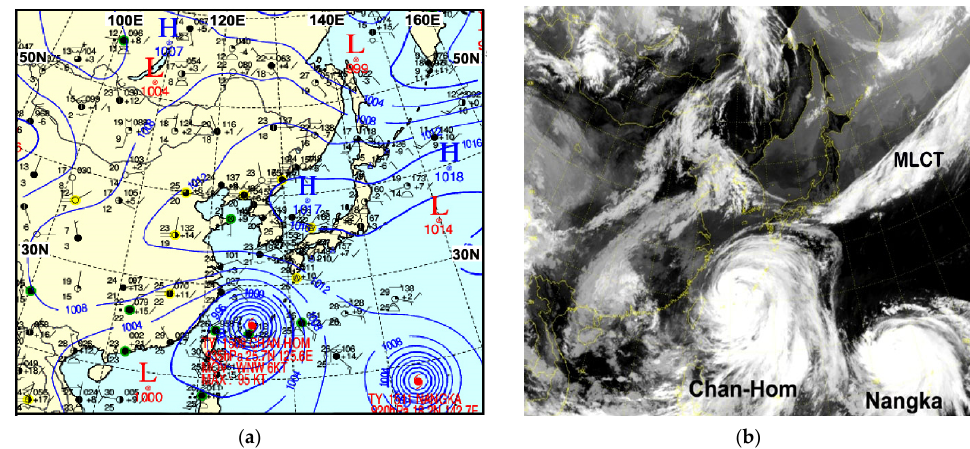
Figure 22. As shown in Figure 3, except for ( a ) surface pressure chart (hPa) and ( b ) COMS-IR satellite